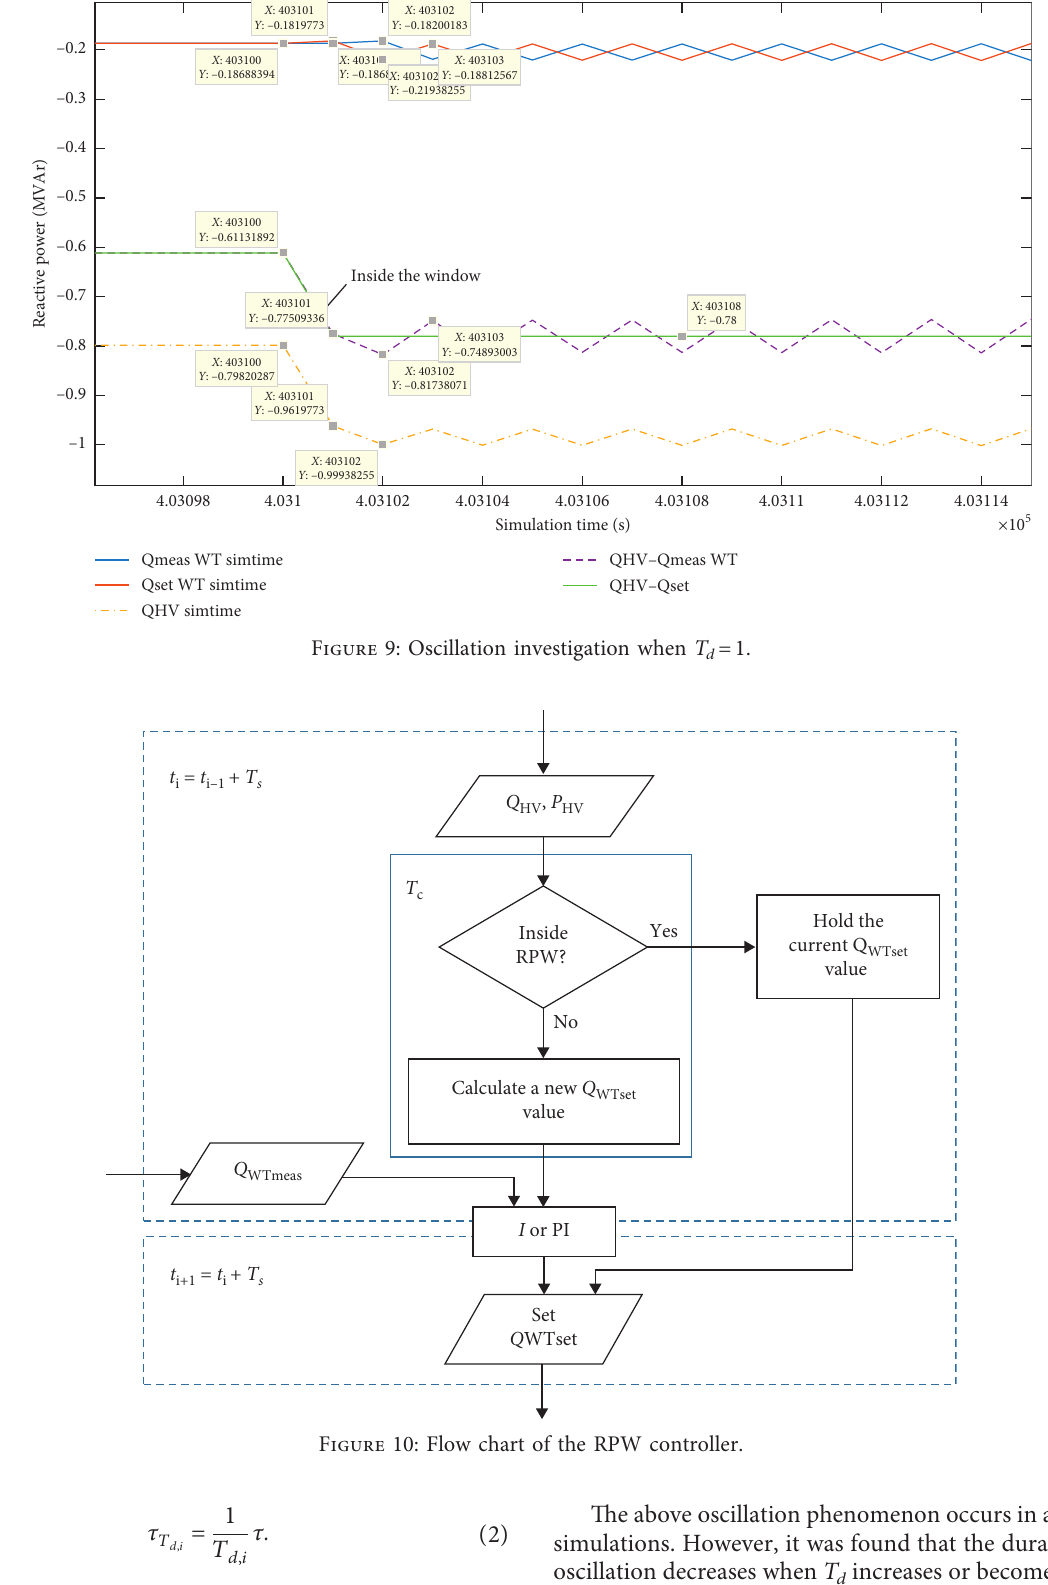
Figure 10: Flow chart of the RPW